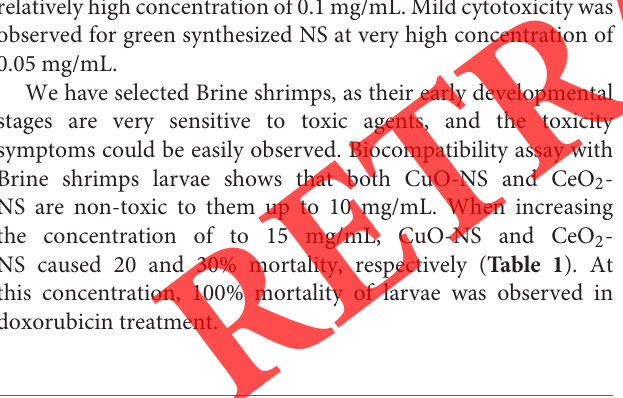
TABLE 1 | Analysis of CuO-NS and CeO 2 -NS, toxicity to Brine shrimp larvae.